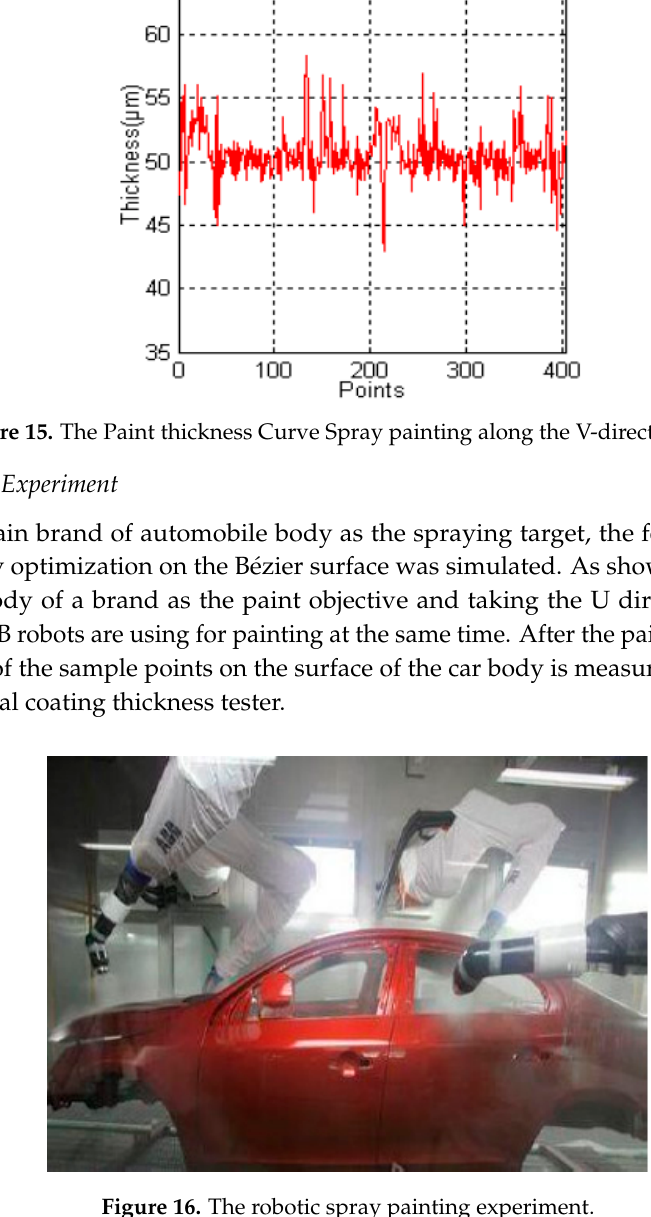
Figure 14. The Paint thickness Curve Spray painting along the U-direction Path.